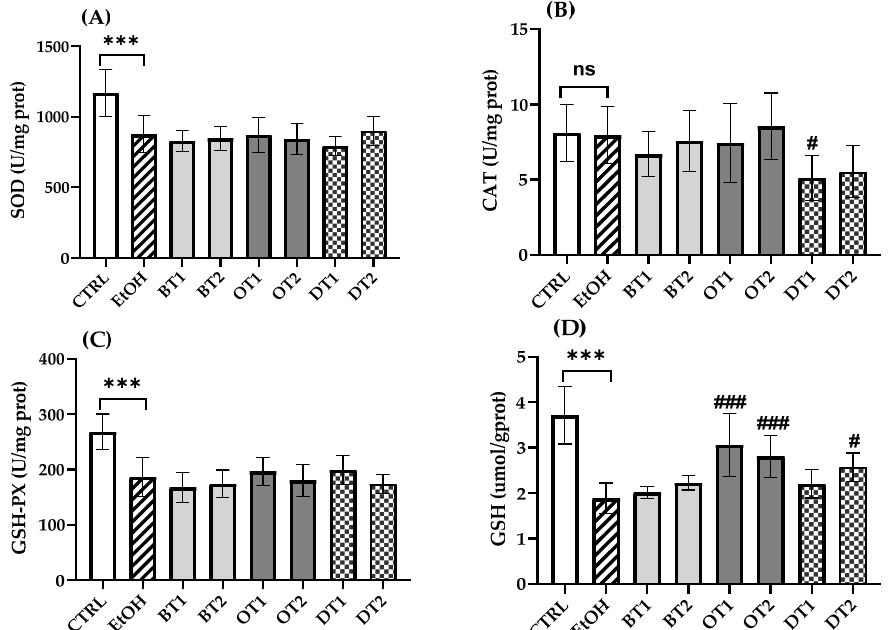
Figure 5. The effects of teas on hepatic antioxidant capacity in mice exposed to chronic alcohol consumption. ( A ) SOD, superoxide dismutase; ( B ) CAT, catalase; ( C ) GSH-Px, glutathione peroxidase; ( D ) GSH, glutathione. CTRL, the control group; EtOH, the model group; BT1, Dianhong Tea; BT2, Yingde Black Tea; OT1, Tieguanyin Tea; OT2, Fenghuang Danzong Tea; DT1, Fu Brick Tea; DT2, Selenium-Enriched Dark Tea. *** p < 0.001, the model group compared with the control group; # p < 0.05, ### p < 0.001, the tea extract supplementary groups compared with the model group.